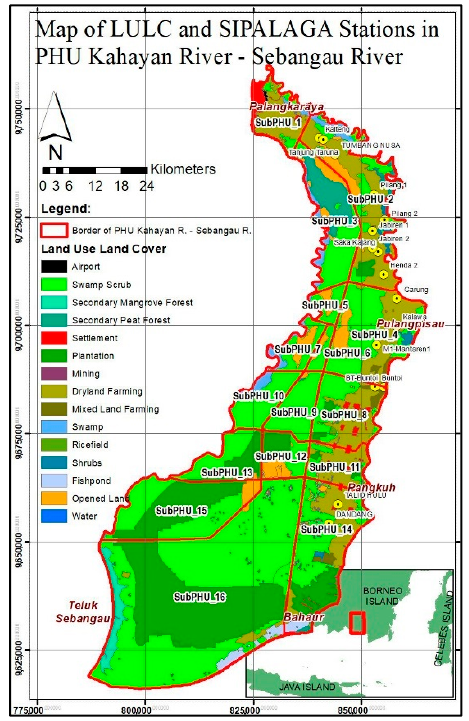
Figure 4. Condition of the LULC of each sub-PHU and position of the Peatland Water Monitoring Systems (SIPALAGA) stations in the Kahayan–Sebangau PHU area (in UTM zone 49 S coordinate system). The red line shows the position of the PHU on the Borneo Island. (data source: